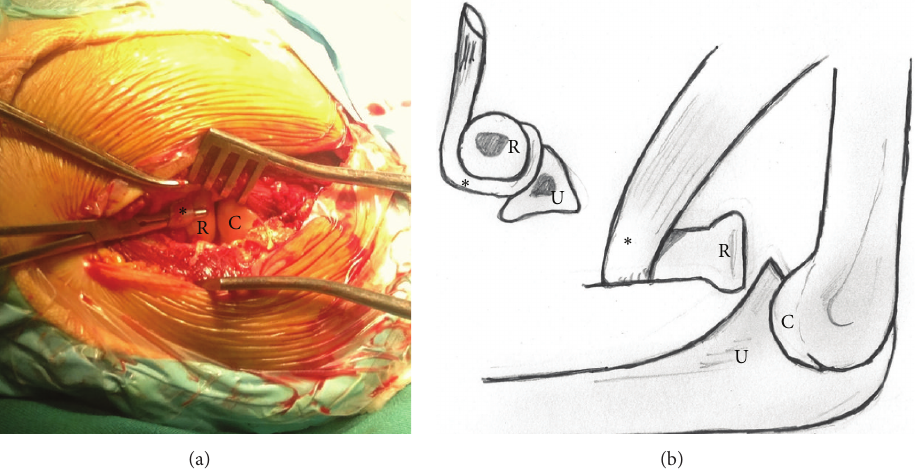
Figure 2: Intraoperative view (a) and injury diagram (b). The displaced biceps tendon prevents reduction of the radial head, keeping it in anteromedial position. R: radial head, C: humeral condyle, U: ulna, and ∗ : biceps